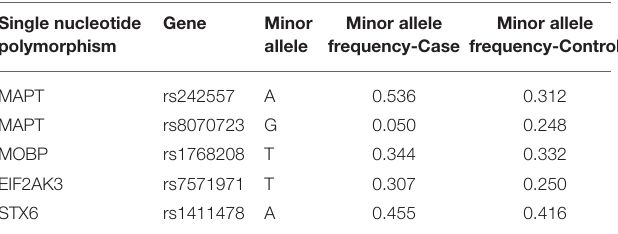
TABLE 2 | Minor allele frequency by participant groups.